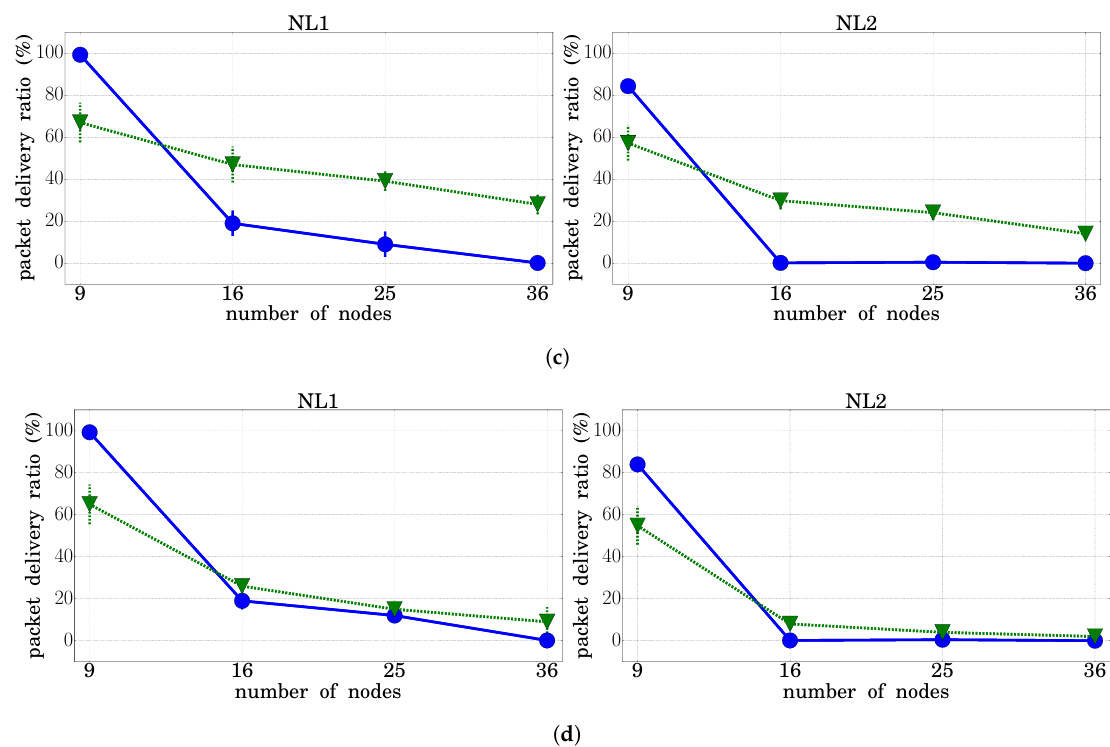
Figure 7. Packet delivery ratio (HWMP vs. MPC-HWMP). ( a ) Traffic Type 1; ( b ) Traffic Type 2; ( c ) Traffic Type 3; ( d ) Traffic Type 4.